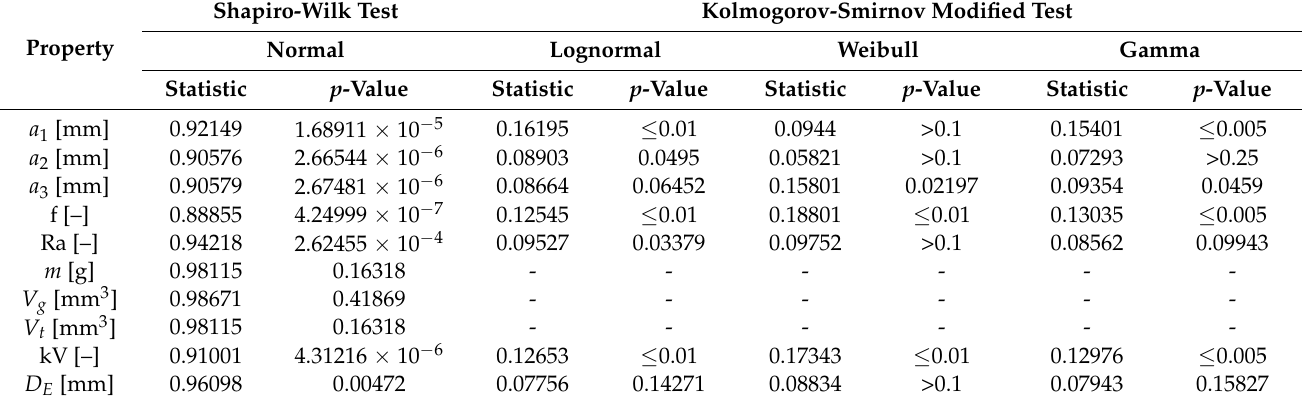
Table 4. Results of the distribution of goodness-of-fit